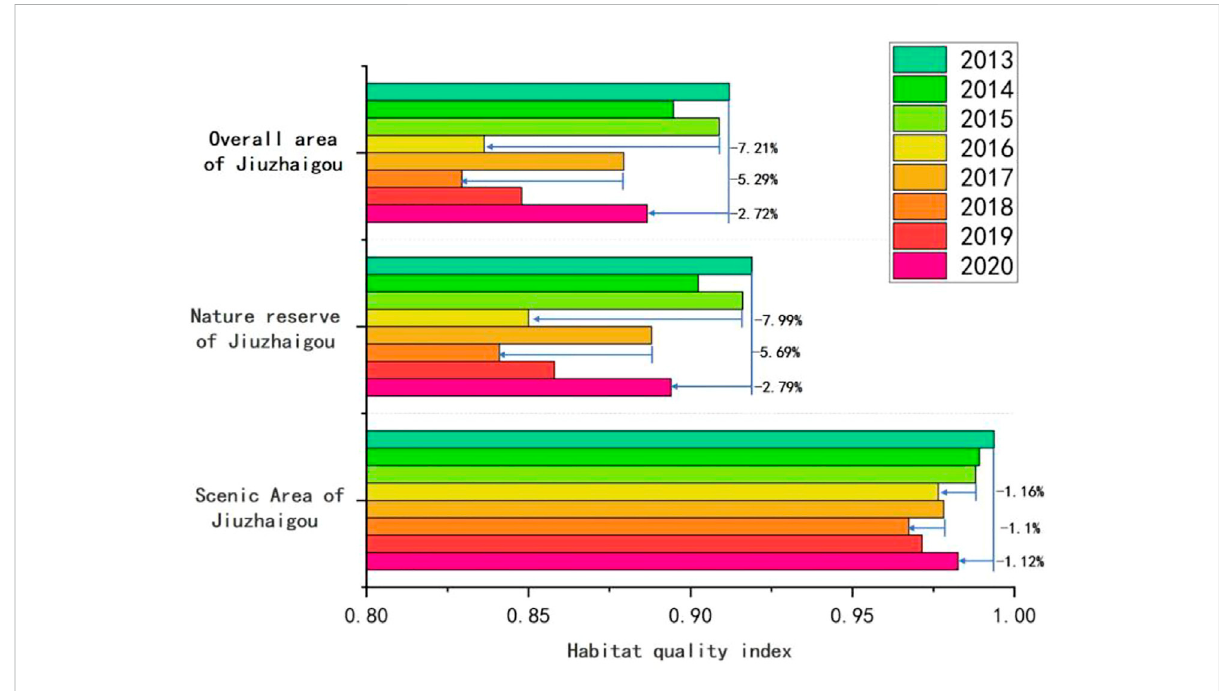
FIGURE 7 Temporal variation of the Habitat Quality Index in Jiuzhaigou.